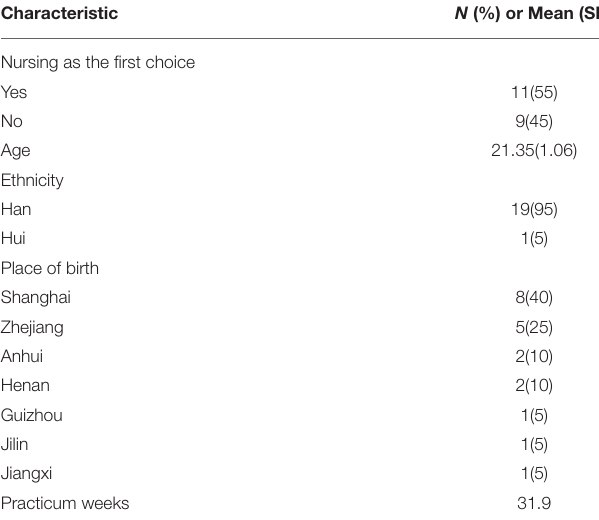
TABLE 2 | Participant characteristics ( n =